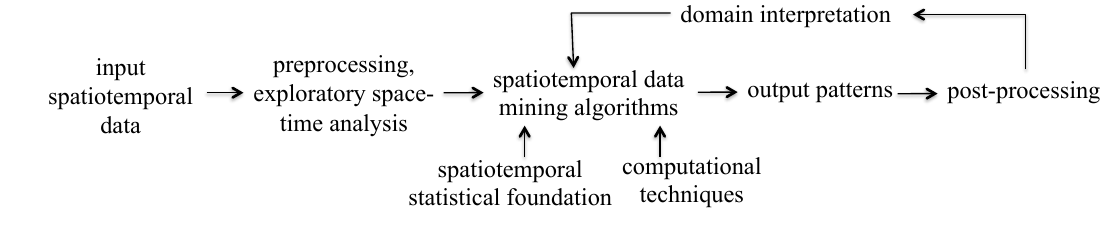
Figure 1. The process of spatiotemporal data